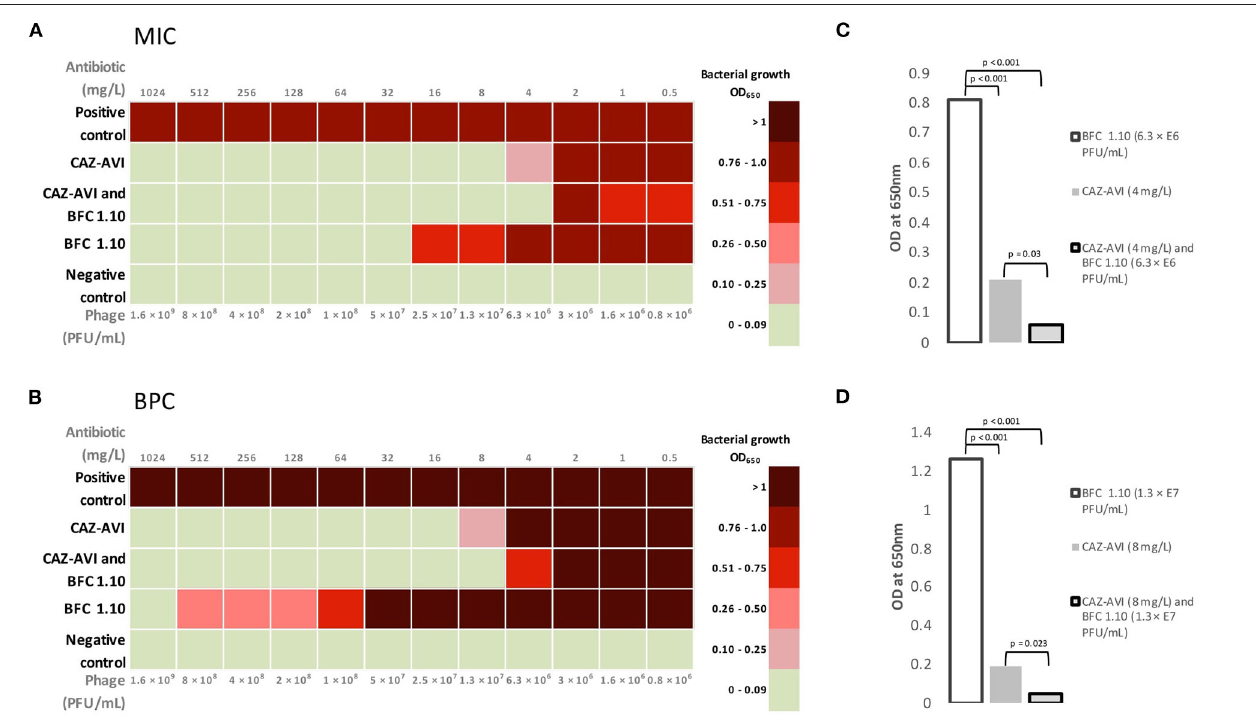
FIGURE 4 | Mean values of minimum inhibitory concentration (A) and biofilm prevention concentration (B) for BFC 1.10 and/or ceftazidime–avibactam. The graph shows the differences between mean minimum inhibitory concentration (C) values using 4 mg/L ceftazidime–avibactam and/or BFC 1.10 6.3 × 10 6 PFU/mL and mean biofilm prevention concentration (D) values using 8 mg/l ceftazidime–avibactam and/or BFC 1.10 3.3 × 10 7 PFU/mL. Results were analyzed using one-way ANOVA with post-hoc Tukey HSD test and were expressed as p -values. MIC, minimum inhibitory concentration; BPC, biofilm prevention concentration; CAZ-AVI,